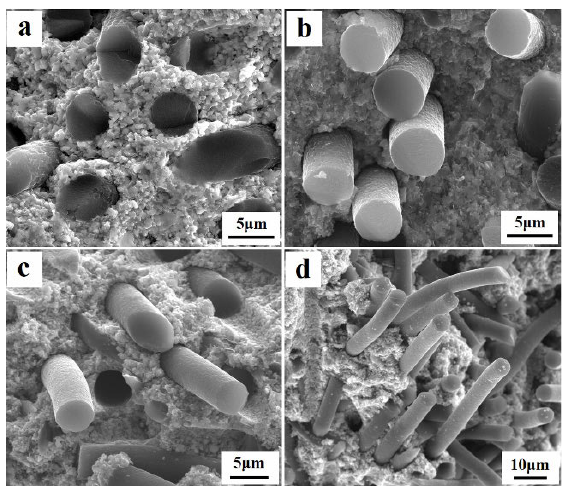
Fig. 3 SEM images of the fracture surfaces of ZrB 2 –SiC–C f composites: (a) ZSC20, (b) ZSC30, (c) ZSC40, and (d) ZSC50, showing that the structural integrity of carbon fibers is well preserved and that the average fiber pullout length increases with increasing fiber content.